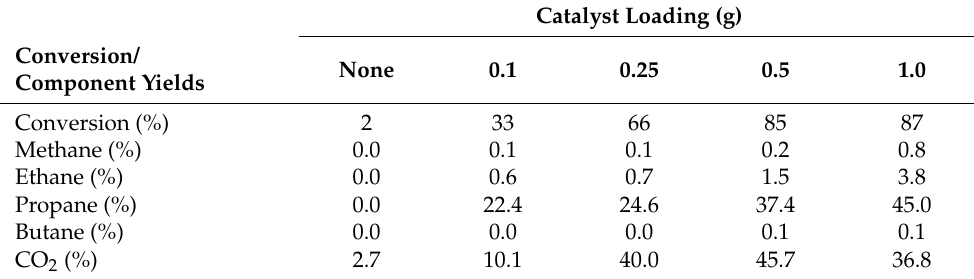
Table 5. Effect of catalyst loading on the conversion of butyric acid and gas yields after 1 h reac- tion time.